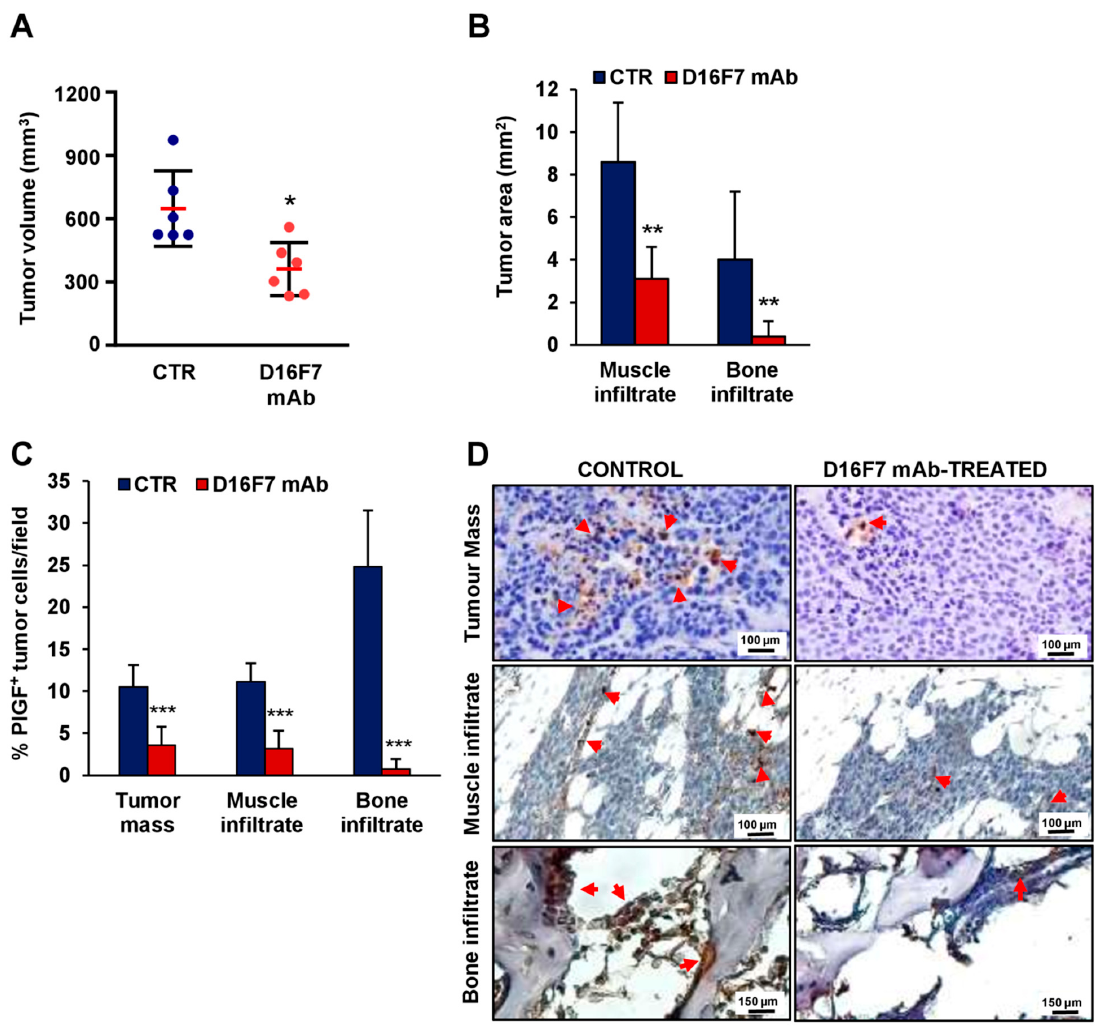
Figure 3. Inhibition of in vivo melanoma growth by the anti-VEGFR-1 D16F7 mAb is associated with a decrease in tissue infiltration by PlGF-positive tumor cells. ( A ) In vivo inhibition of B16F10 melanoma growth by D16F7 mAb. Mice were treated i.p. with the mAb (10 mg/kg) or with PBS as mAb vehicle (CTR), and tumor size (mm 3 ) was measured as indicated in the Materials and Methods section. The plot shows differences in melanoma size between control and treated mice on day 12 after tumor challenge (i.e., when the tumor size in control mice reached half of the admissible size). Red horizontal lines indicate the arithmetic mean of tumor size ± SD ( n = 6). Statistical analysis was performed by Mann–Whitney U test: *, p < 0.05. ( B – D ) On day 12, three animals were sacrificed for each experimental condition, and tumors were excised and processed for immunohistochemical analysis. ( B ) Morphometric evaluation of muscle and bone tumor infiltration in control and D16F7 mAb-treated mice (7 microscopic fields/group). Statistical analysis of the differences between D16F7 mAb-treated and control samples was performed by Student’s t -test (normal distribution): **, p < 0.01. ( C ) Analysis of the percentage of PlGF-positive B16F10 melanoma cells in control and D16F7 mAb- treated tumors and surrounding tissues. Sections from three tumor specimens/group were stained for murine PlGF, and the percentage of B16F10 cells positive for PlGF present in the tumor mass and in the tumor infiltrating the bone or the skeletal muscle was calculated. The histogram represents the mean of 14 microscopic fields for each experimental group ± SD. Statistical analysis of the differences between D16F7 mAb-treated and control samples was performed by Student’s t -test (normal distribution): ***, p < 0.001. ( D ) Representative photographs showing PlGF staining (in tumor mass and muscle infiltrate photographs, the scale bars represent 100 µ m; in bone infiltrate photographs, the scale bars represent 150 µ m). Arrows point to positively stained